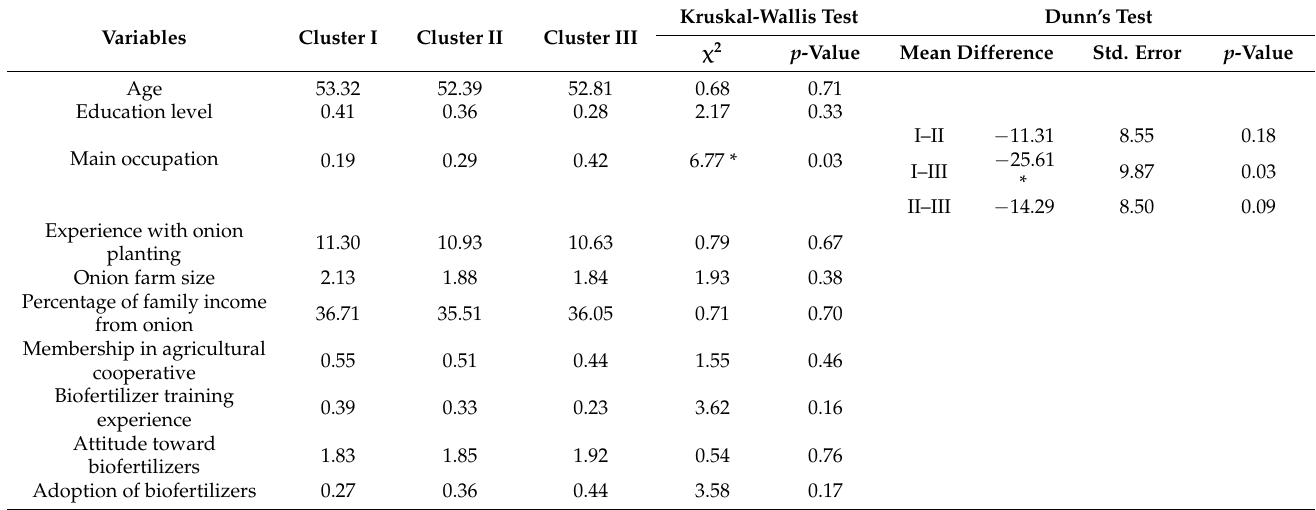
Table 5. Differences among clusters of information-seeking behavior according to farmers’ socioeconomic characteristics.